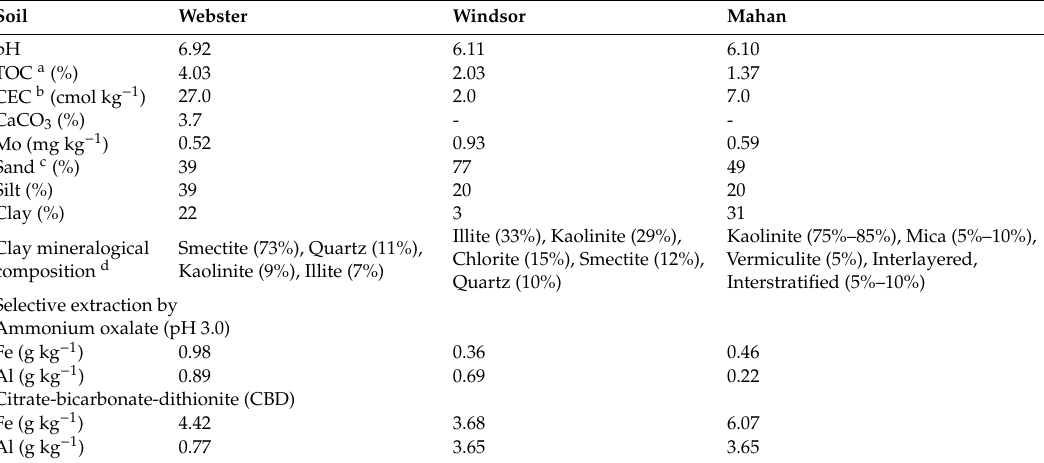
Table 1. Selected physical and chemical properties of the soils